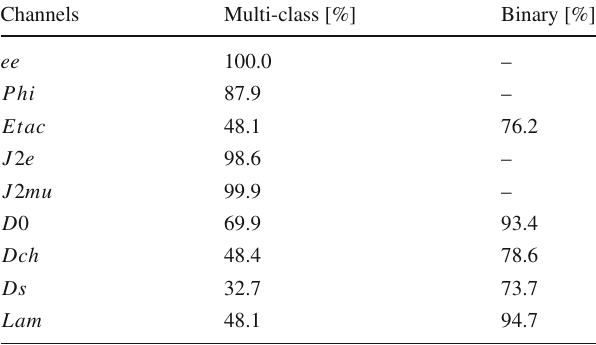
Table 4 The comparison on the individual trigger efficiencies of truth matched events between multi-class classification and binary classifi- cation based on a DNN for an overall background rejection of 1/1000 over all trigger lines